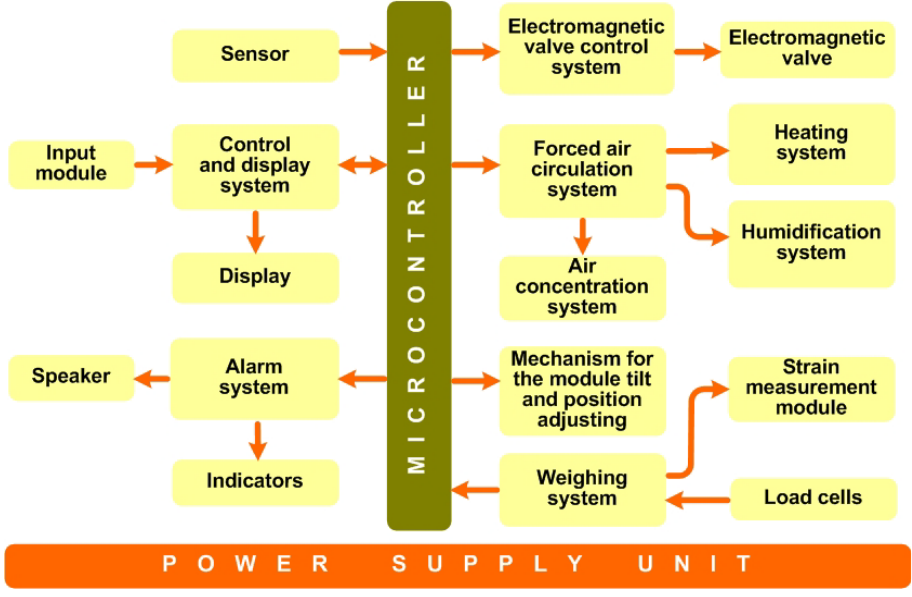
Figure 3. Block diagram for the technical device.